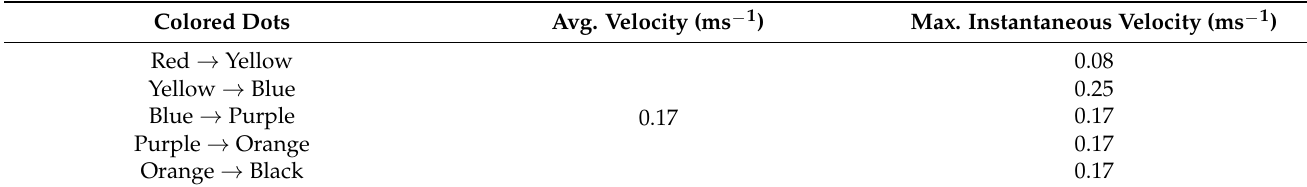
Table 2. Velocity from dye tracking at Haeundae Beach.